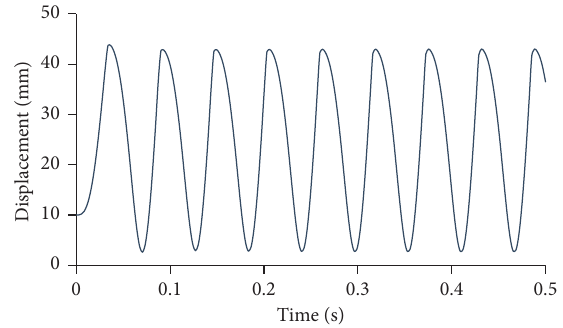
Figure 4: Displacement curve of impact piston.